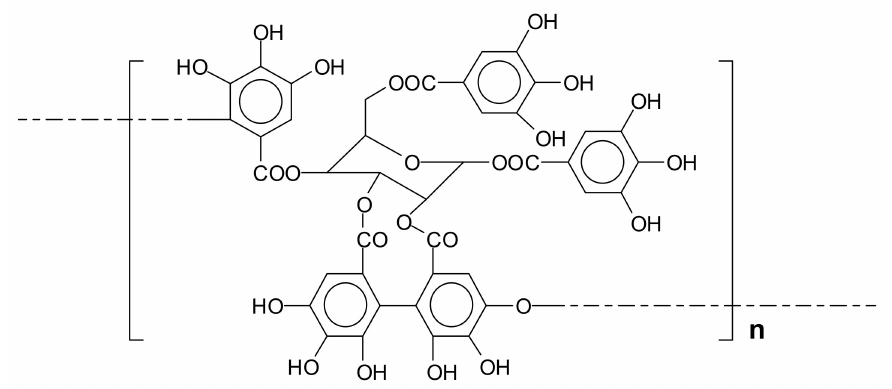
Figure 2. Schematic representation of the repeating unit of the ellagi-tannin of chestnut wood.